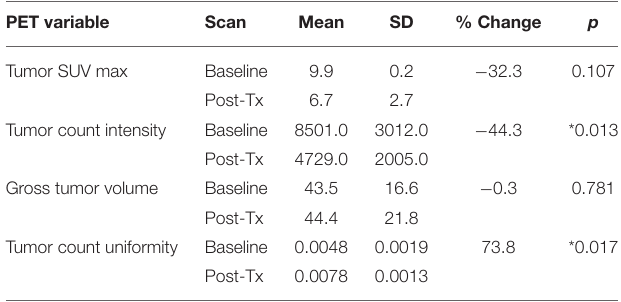
radiation therapy (ZOL + RT) for appendicular osteosarcoma. PET